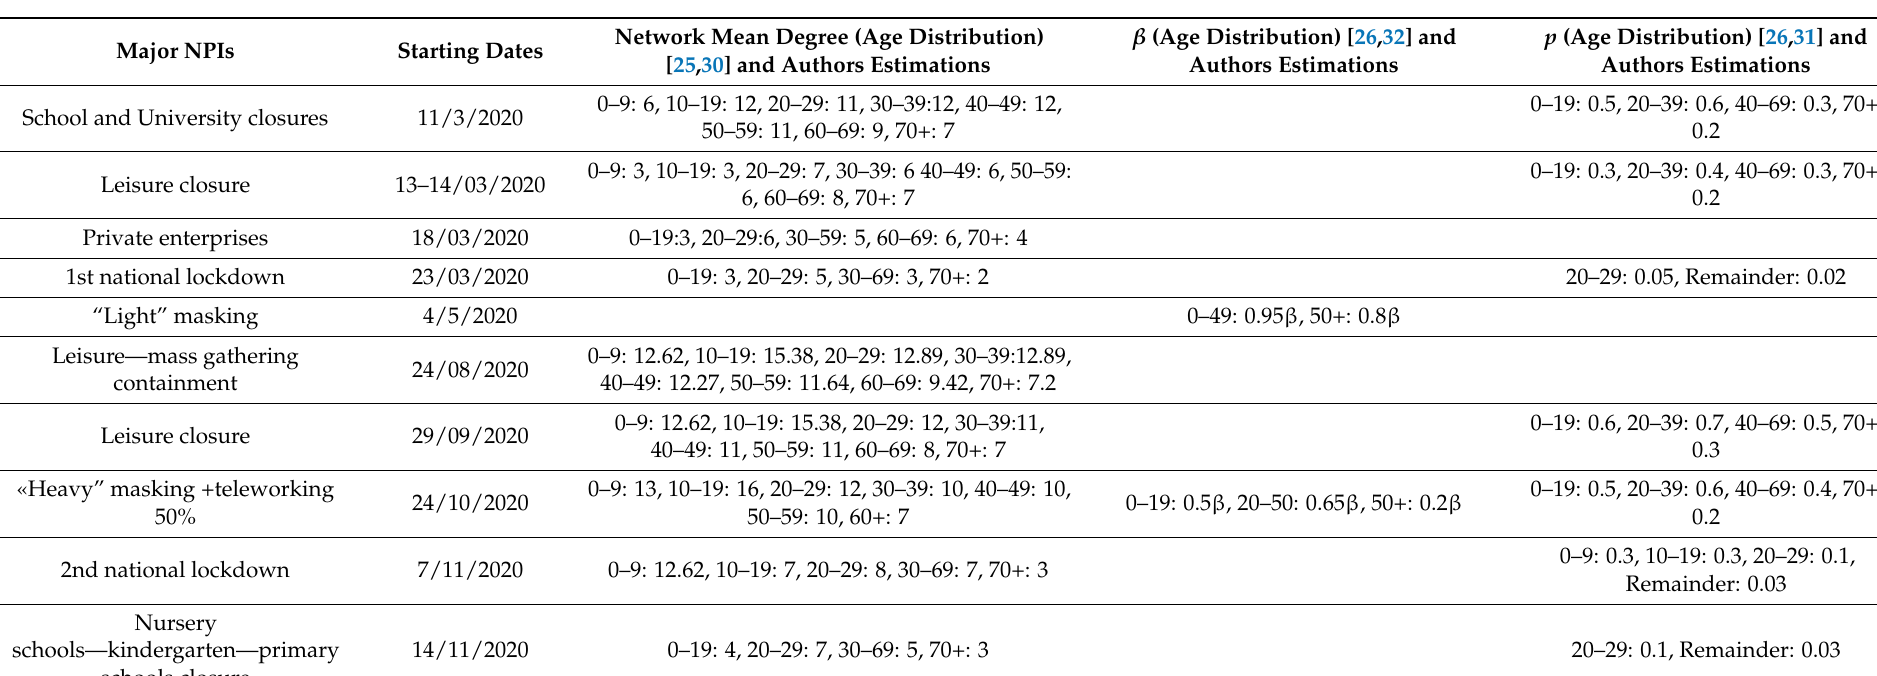
Table 4. Major NPIs effects on the model parameters’ values used of the Phase-1 SEIR and Phase-2 SVEIR models used to assess COVID-19 transmission dynamics in Greece. Major